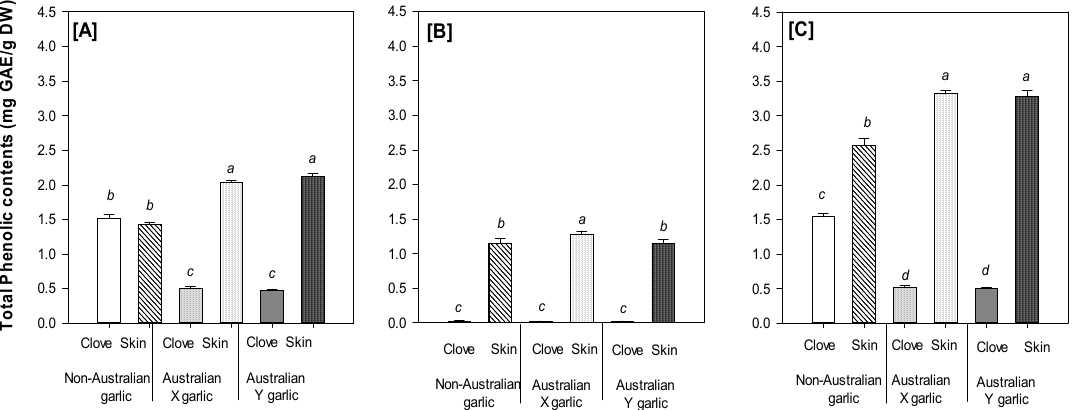
Figure 1. ( A ) Free, ( B ) bound, and ( C ) total (free + bound) TPC of di ff erent garlic cultivars and tissues. Data present mean ± SD ( n = 3). Di ff erent letters in the same figure indicate significant di ff erence at α = 0.05.